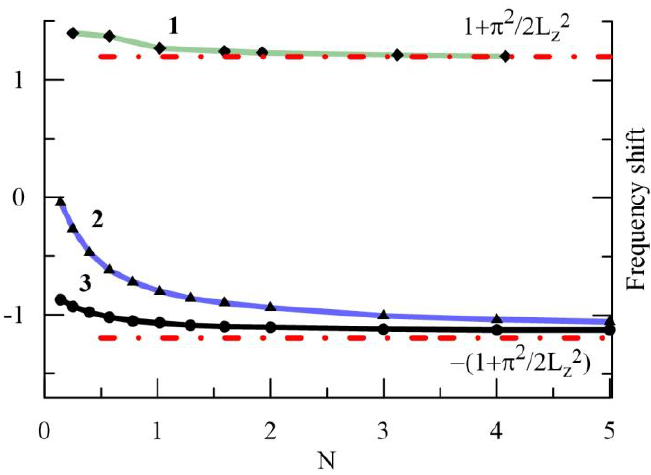
Fig. 3. Spatial structures of the symmetric (left) and the anti-symmetric (right) modes. 5 8 L  , 1 N  . x